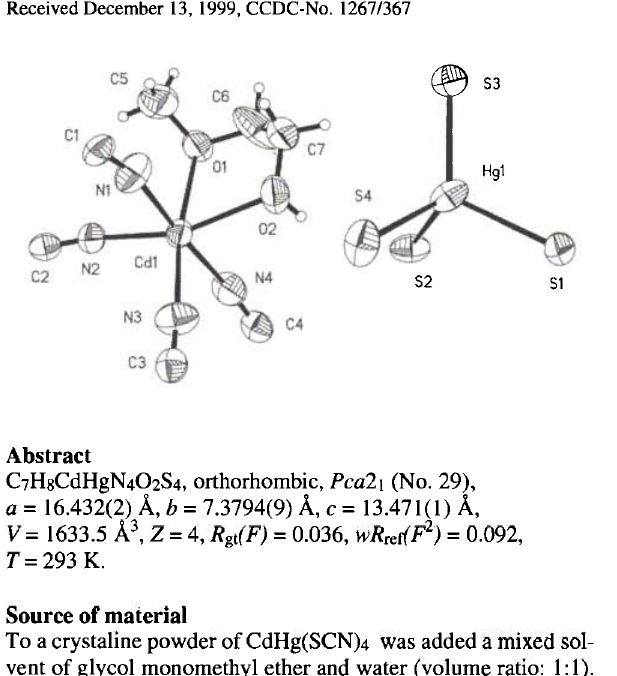
Table 1. Data collection and handling.